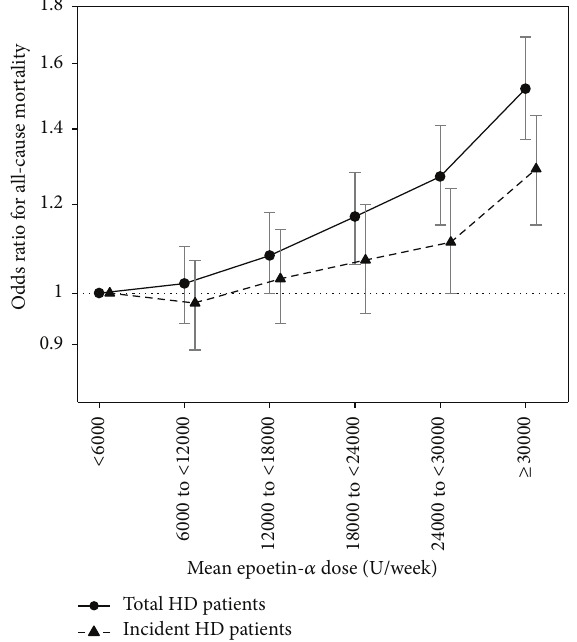
Figure 2: Adjusted mortality risk for all-cause mortality by weekly epoetin- 𝛼 dose estimated by marginal structural